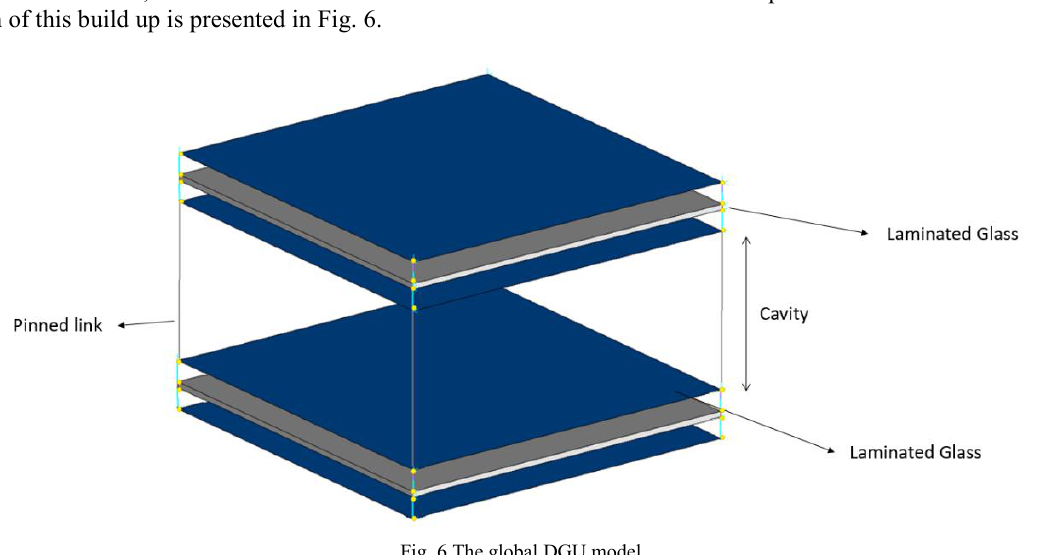
Fig. 6 The global DGU model.